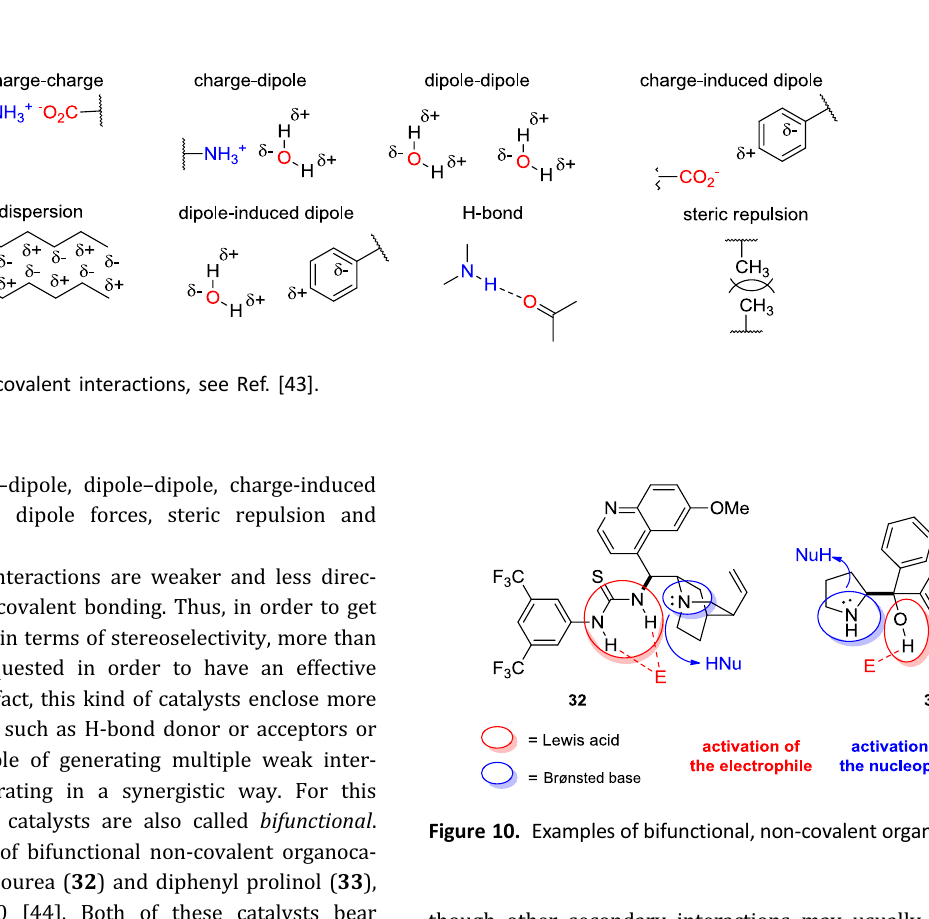
Figure 8. Two examples of catalytic enantioselective epoxidation of enals. (a) from Ref. [38], (b) from Ref. [39] and (c) hypothesized mechanism.